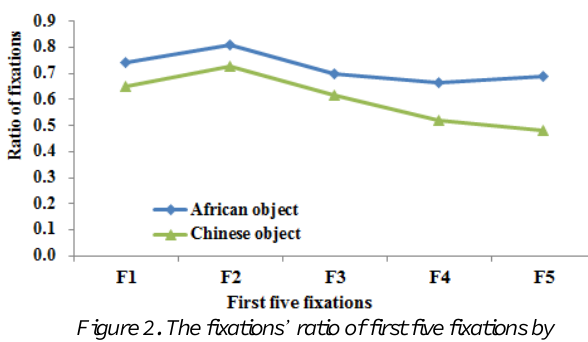
Figure 2. The fixations’ ratio of first five fixations by condition in study phase